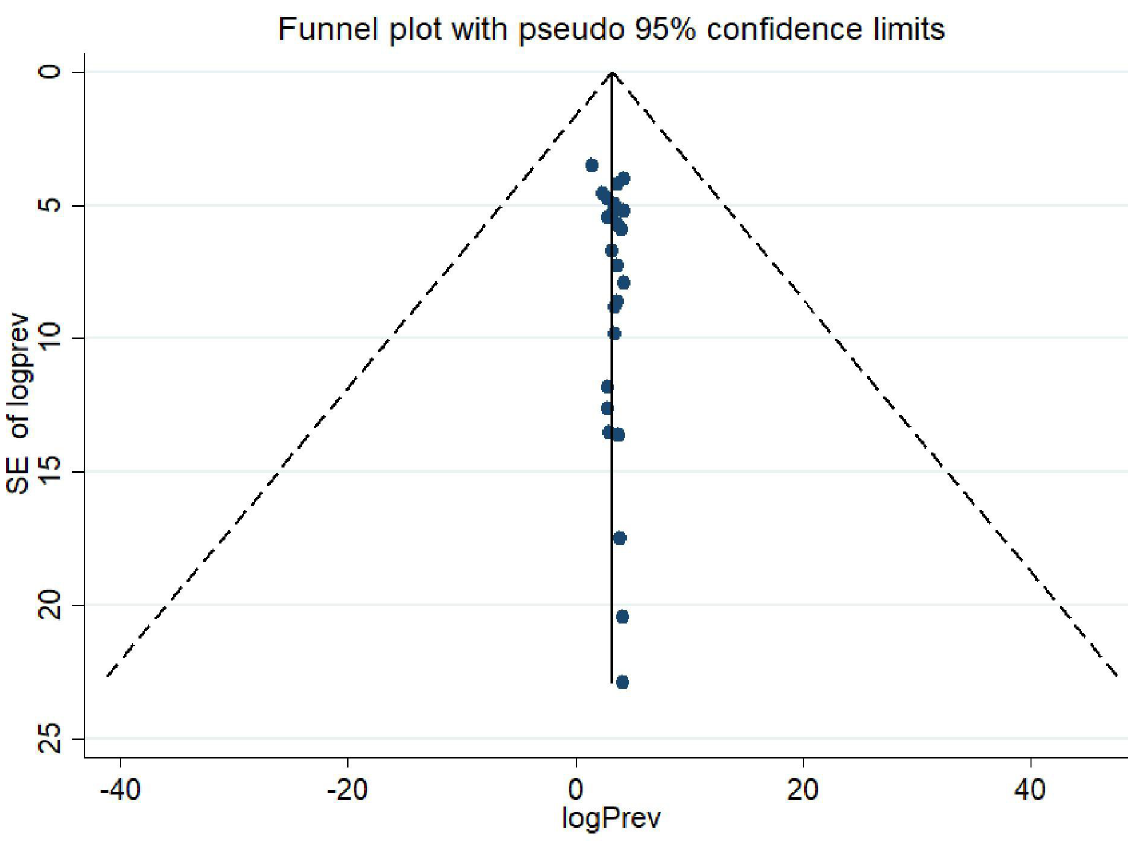
Fig 3. Egger’s funnel plot indicates absence of publication bias across the included studies,